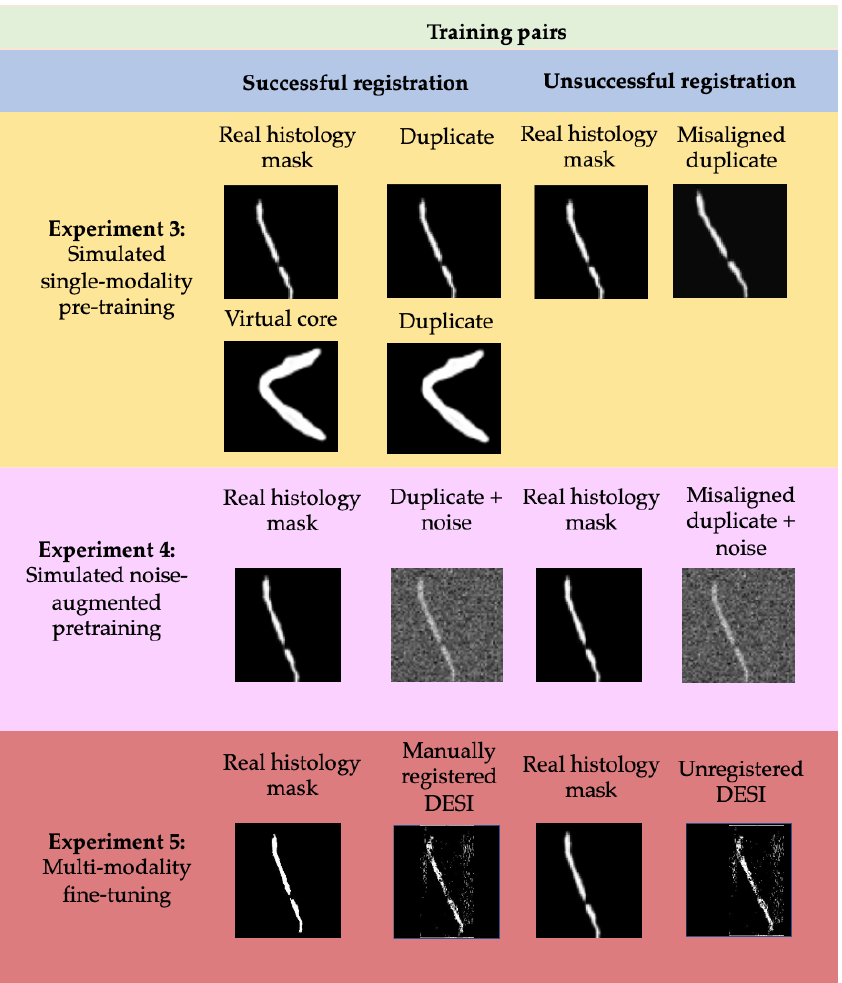
Figure 7. Training pairs used for training the second half of the network iteratively. Both successful and unsuccessful registrations are considered. and unsuccessful registrations are